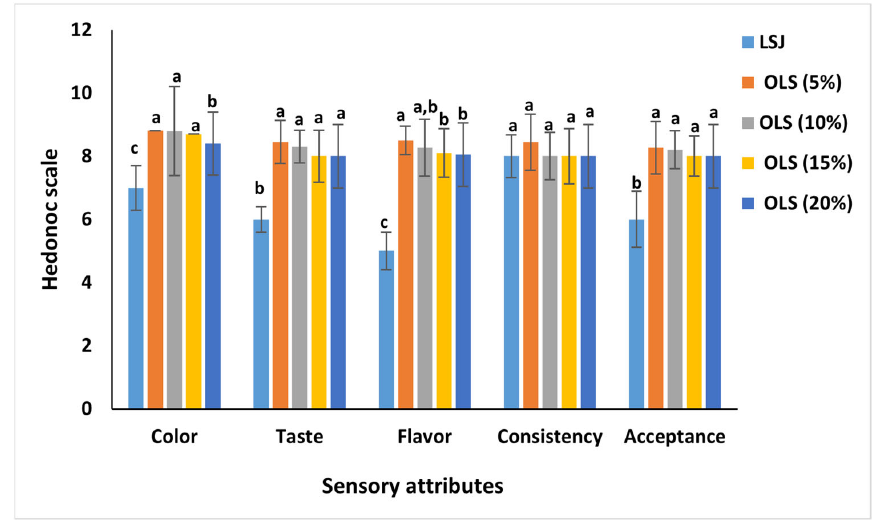
Figure 4. Sensory evaluation of orange juice mixed with beetroot leaf–stem juice in different pro ‐ portions. Column in each group labeled with different letters are significantly different at p <